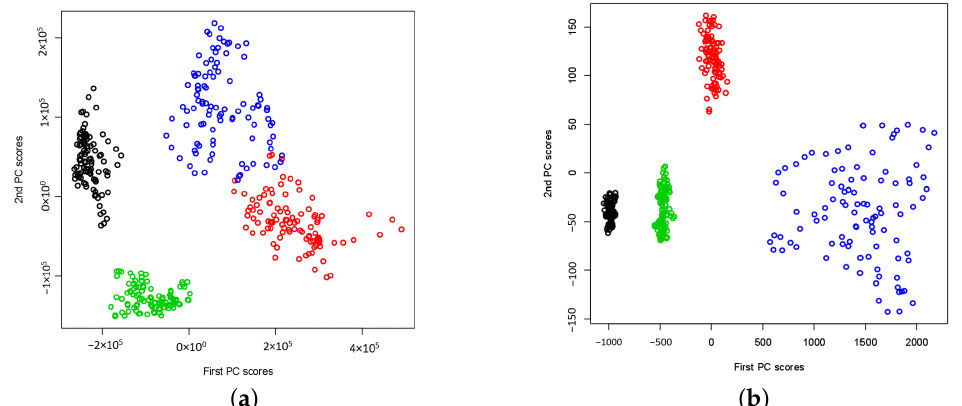
Figure 1. The plots of extracted two-dimensional principal component scores of wavelet power spec- tra for data sets A (Normal: Eyes Closed, Black), B (Normal: Eyes Open, Red), C (Non-epileptogenic zone, Green) and D (Epileptogenic zone, Blue) respectively. Both I ( a ) and I ( m ) consist of wavelet power spectra from sets A, B, C and D. ( a ) Using CWT, ( b ) Using DWT.